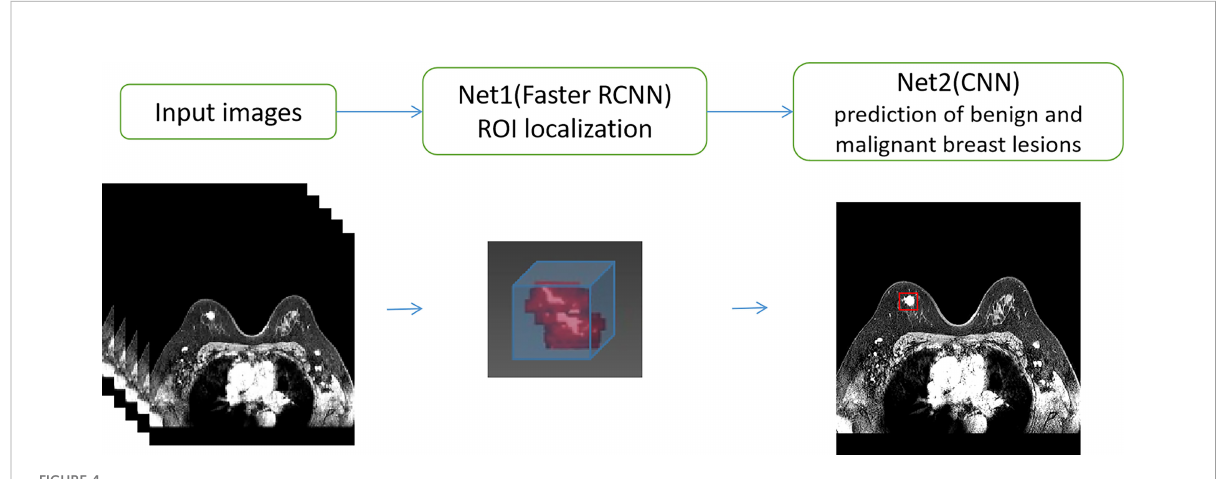
FIGURE 4 The pipeline of the system consisting of CNN and Faster